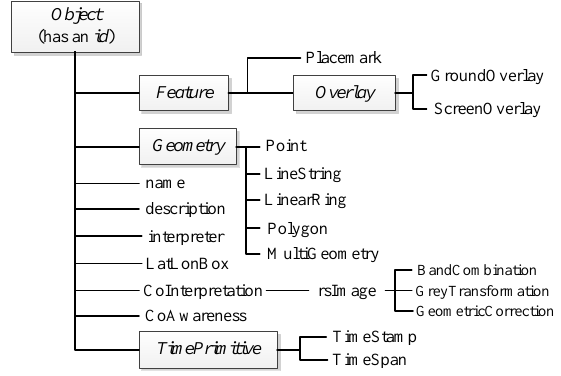
Figure 3. Main KML elements adopted for interpretation